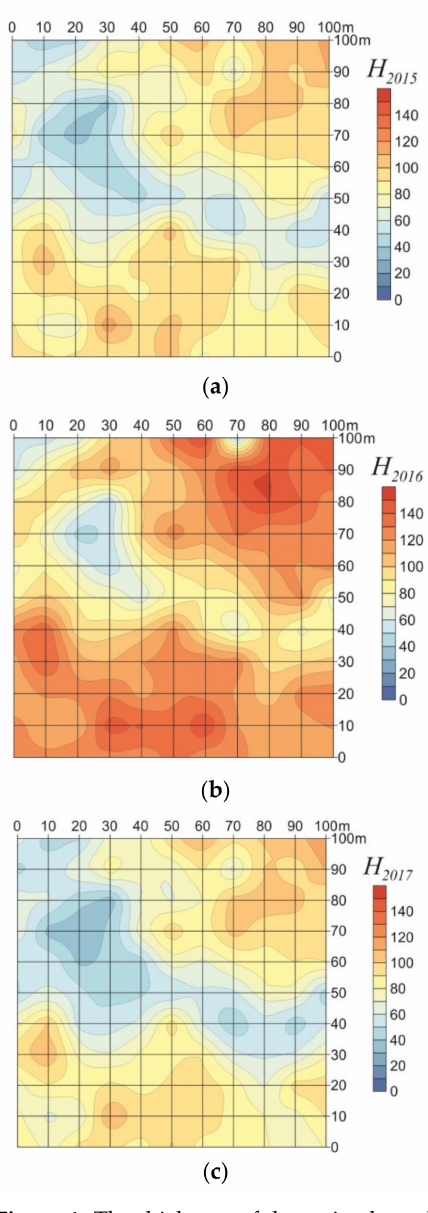
Figure 4. The thickness of the active layer H (cm) in the Kashin area (CALM R24A-1) in 2015 ( a ), 2016 ( b ), and 2017 ( c